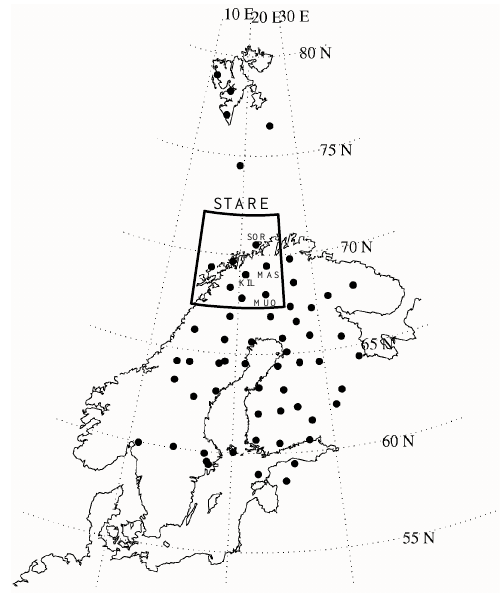
Fig. 1. Location of the IMAGE and BEAR magnetometer stations (dots) in Northern Scandinavia, and the field of view of the STARE radar (black